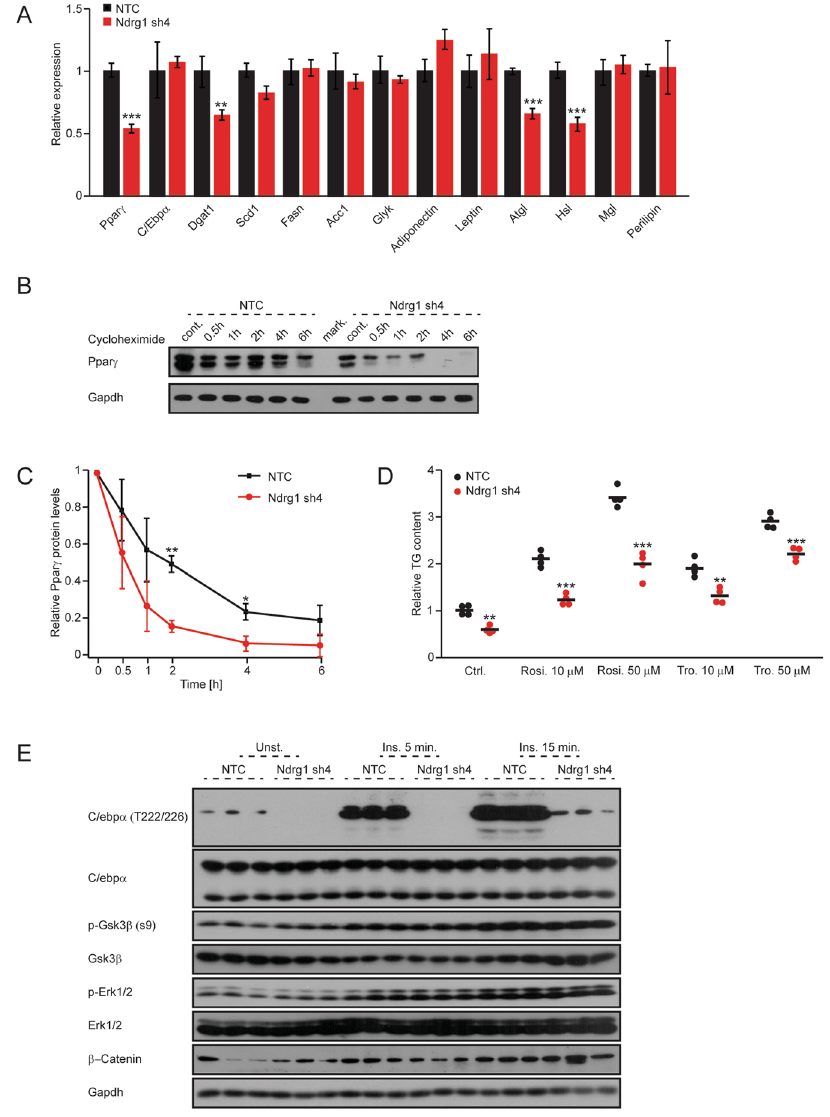
Figure 2. Ndrg1 promotes Ppar γ expression and stability as well as C/Ebp α phosphorylation. ( A ) Relative mRNA levels for indicated genes in control and Ndrg1-deficient differentiated 3t3l1 cells. (n = 3, * P < 0.05, ** P < 0.01, *** P < 0.001 according to t-test). ( B ) Western blot for Ppar γ and Gapdh in control and Ndrg1- depleted differentiated 3t3l1 cells stimulated with cycloheximide for indicated time points. Representative picture was chosen from three biological replicates. ( C ) Quantification of relative amount of Ppar γ in cells treated with cycloheximide in relation to the initial (without treatment) levels of Ppar γ in respective control and Ndrg1-depleted cells (n = 3, * P < 0.05, ** P < 0.01 according to t-test). ( D ) Relative TG content in control and Ndrg1 sh 3t3l1 cells subjected to adipocyte differentiation cocktail with rosiglitazone (Rosi) or troglitazone (Tro). Each data point represents a biological replicate. Stars indicate significance for given parameters between control and Ndrg1-depleted cells. ( * P < 0.05, ** P < 0.01, *** P < 0.001 according to ANOVA followed by the Post hoc Tukey test). ( E ) Western blot analysis using indicated antibodies in control and Ndrg1-deficient cells stimulated with insulin (Ins.) for the indicated